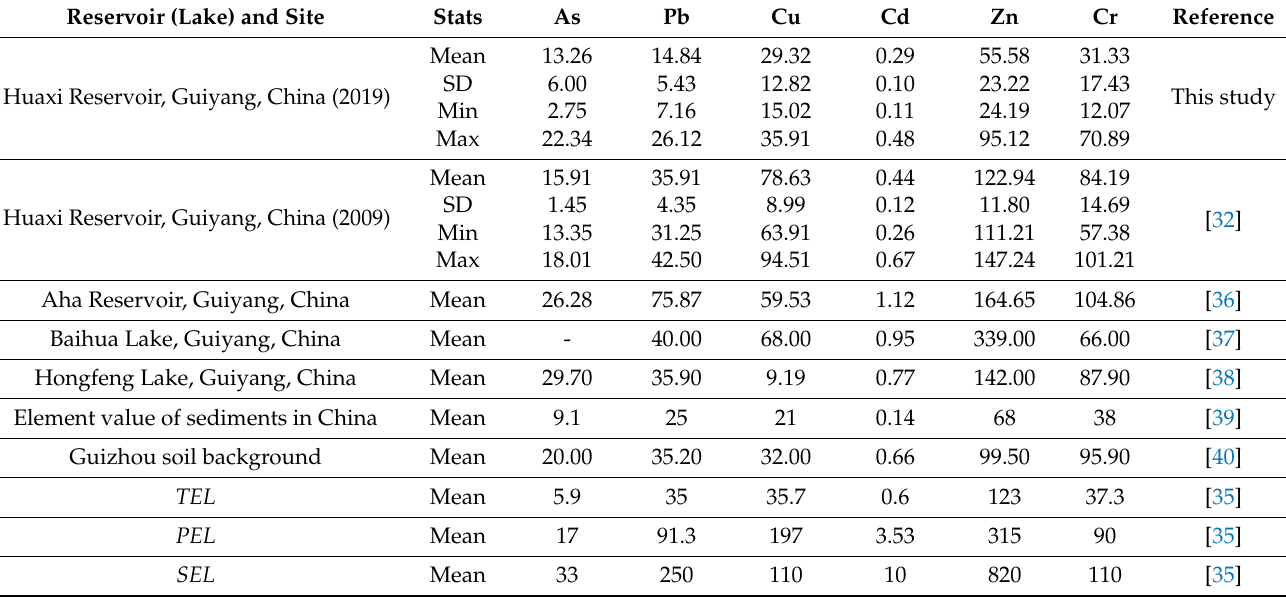
Table 1. Concentrations of heavy metals in the sediments of the Huaxi Reservoir and other nearby reservoirs, the background values and sediment quality guidelines